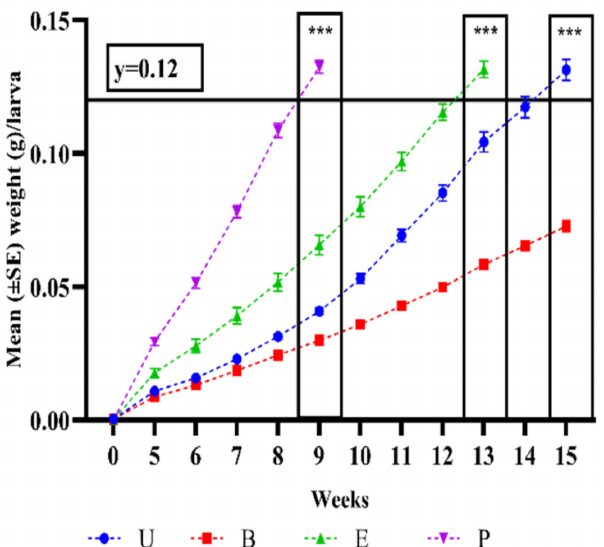
Figure 1. Average body weight (g) of individual Tenebrio molitor larvae in the four probiotic treat- ment groups during the experimental period of 15 weeks. Horizontal reference line at Y = 0.12 g indicates the threshold weight of the larvae to harvest. Blue: control (C); red: Bacillus subtilis (B); green: Enterococcus faecium (E); and violet: Pediococcus pentosacceus (P). Each treatment group consisted of 10 subgroups, each with 100 larvae. Larvae were harvested at three time points: P larvae at week 9, E larvae at week 13, and C larvae at week 15, as indicated by final data points. The bars in each curve represent the standard error ( ± SE) from the mean weight. Significant differences ( p < 0.0001) in larval weight at weeks 9, 13, and 15 are indicated by